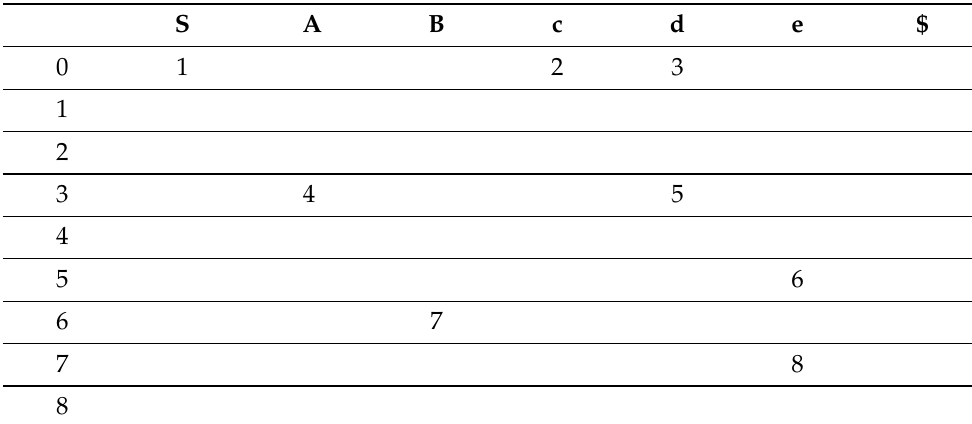
Table 4. The goto table T G for the specification Ξ in (4).